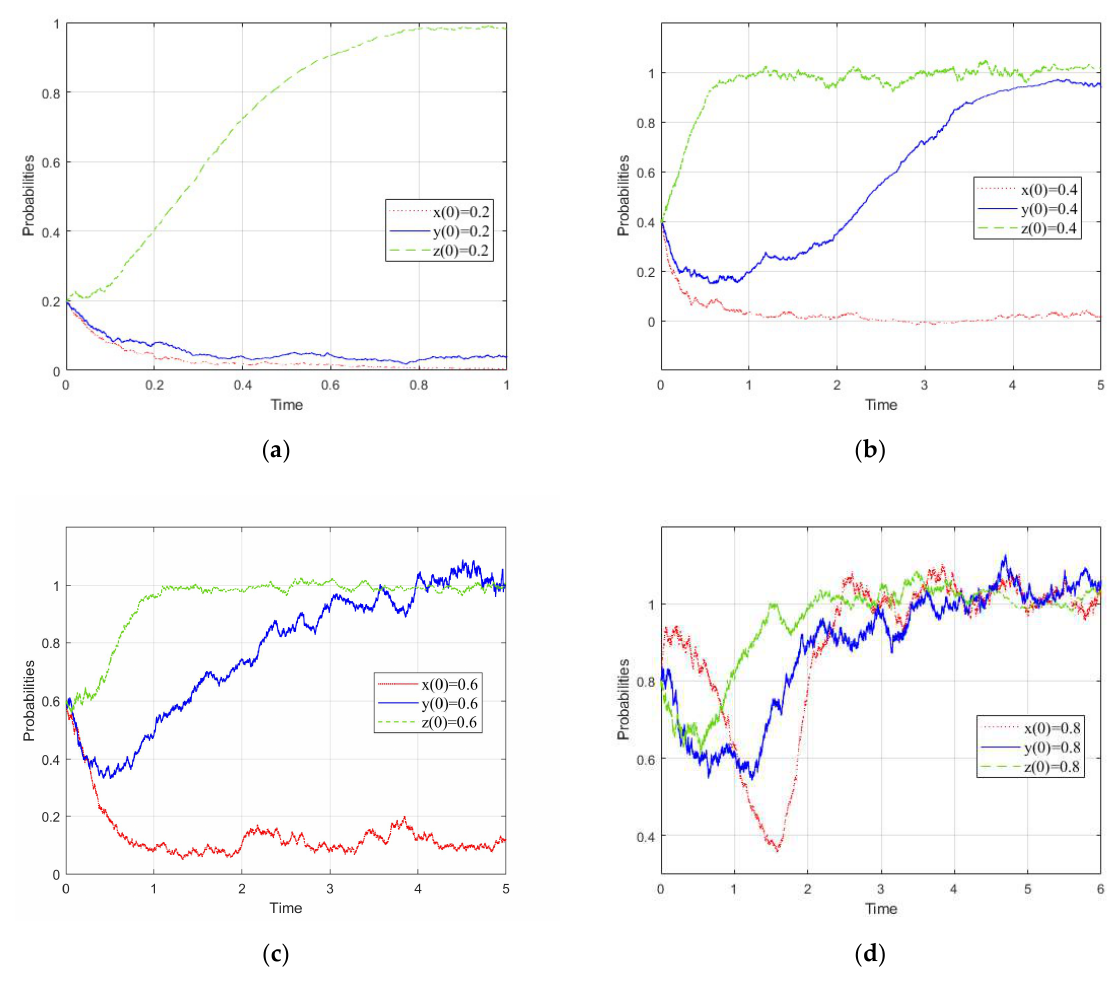
Figure 2. Influence rule of the initial probabilities on three governments: ( a ) influence rule of the initial probabilities on three governments when x (0) = 0.2, y (0) = 0.2, z (0) = 0.2, ( b ) influence rule of the initial probabilities on three governments when x (0) = 0.4, y (0) = 0.4, z (0) = 0.4, ( c ) influence rule of the initial probabilities on three governments when x (0) = 0.6, y (0) = 0.6, z (0) = 0.6, and ( d ) influence rule of the initial probabilities on three governments when x (0) = 0.8, y (0) = 0.8, z (0) = 0.8.